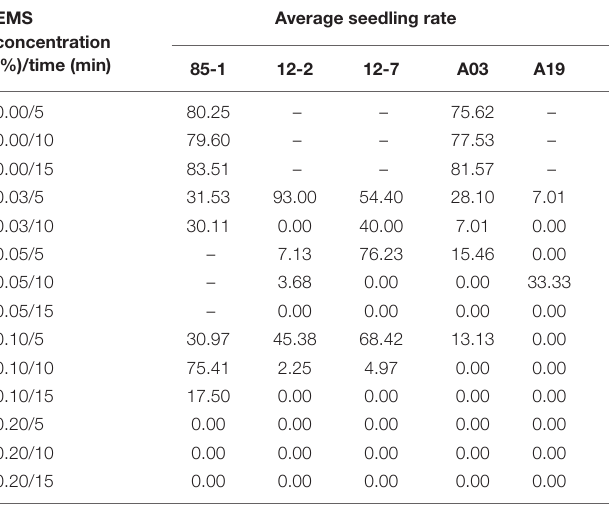
TABLE 2 | Average seedling rate of five Chinese cabbage genotypes treated with different concentrations of EMS for different